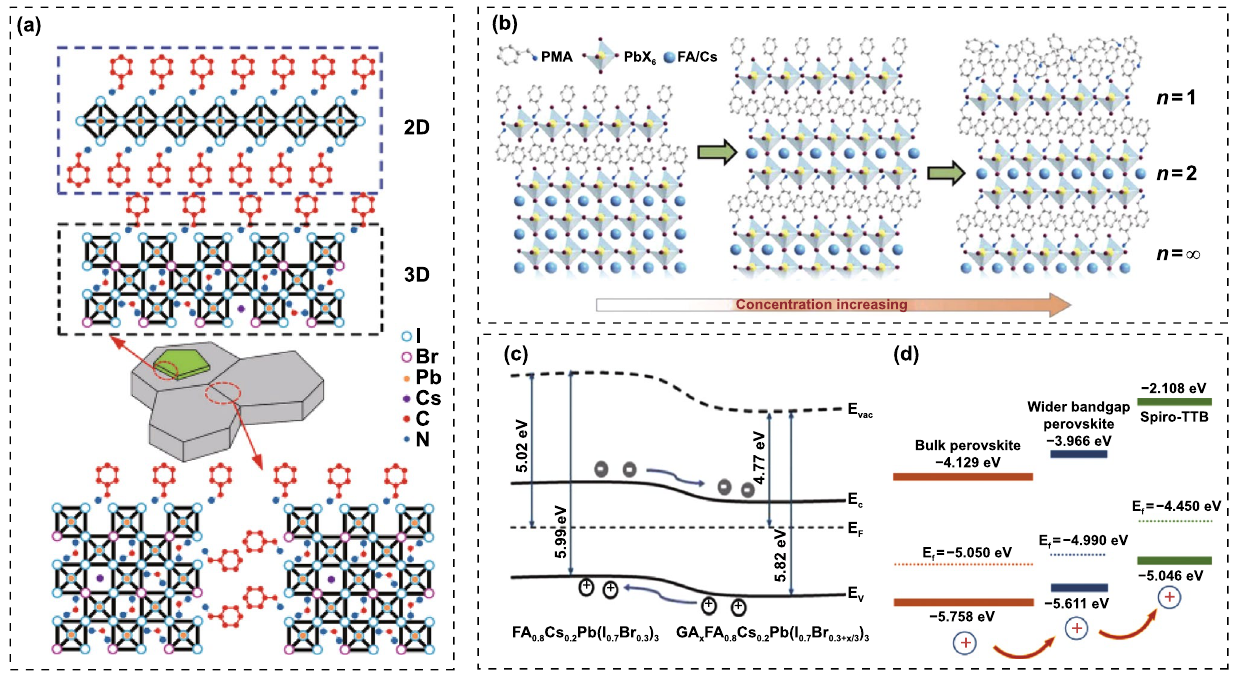
Fig. 13 a Schematic of BA modification on the Cs 0.15 FA 0.85 Pb(I 0.73 Br 0.27 ) 3 thin film. Reproduced with permission from Ref. [211]. Copyright 2017, Wiley–VCH. b Schematic perovskite films treated with low, medium or high concentrations of PMABr/IPA solution. Reproduced